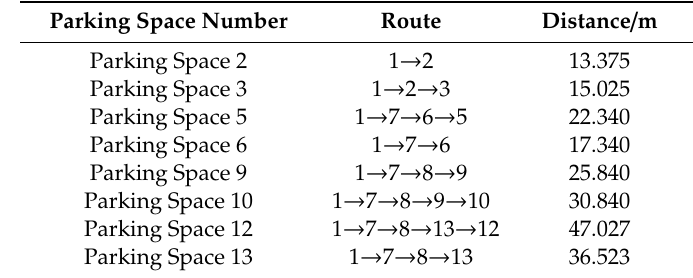
Table 1. Shortest route and distance from the starting point to each parking space.